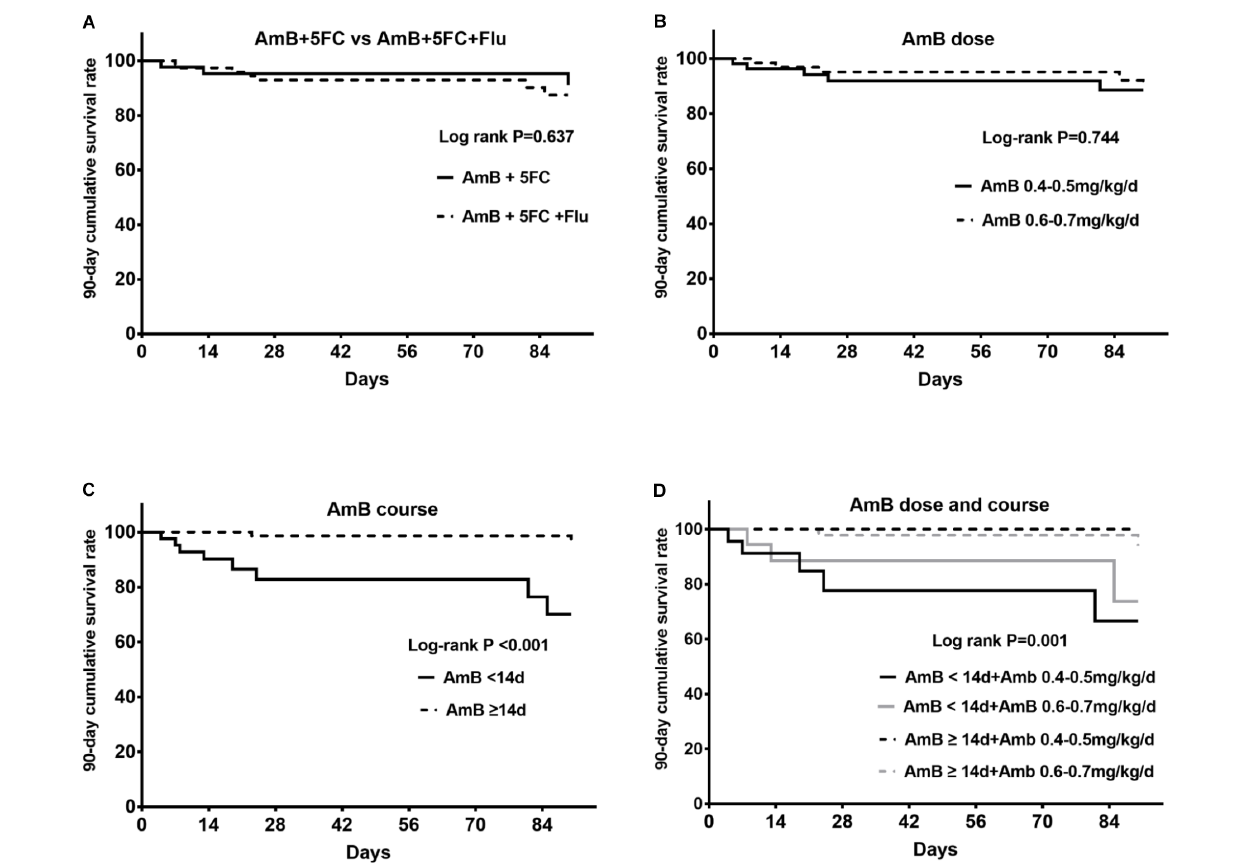
FIGURE 2 | (A) The 90-day cumulative survival rates between the AmB + 5FC group and the AmB + 5FC + Flu group were similar ( P = 0.637). (B) The 90-day cumulative survival rate in patients treated with AmB doses of 0.3–0.5 mg/kg/d and 0.5–0.7 mg/kg/d ( P = 0.744). (C) The 90-day cumulative survival rate in patients treated with AmB for < 14 days and ≥ 14 days (log-rank P < 0.001). (D) Combined effects of the AmB dose and course on the 90-day cumulative survival rate of patients (log-rank P =